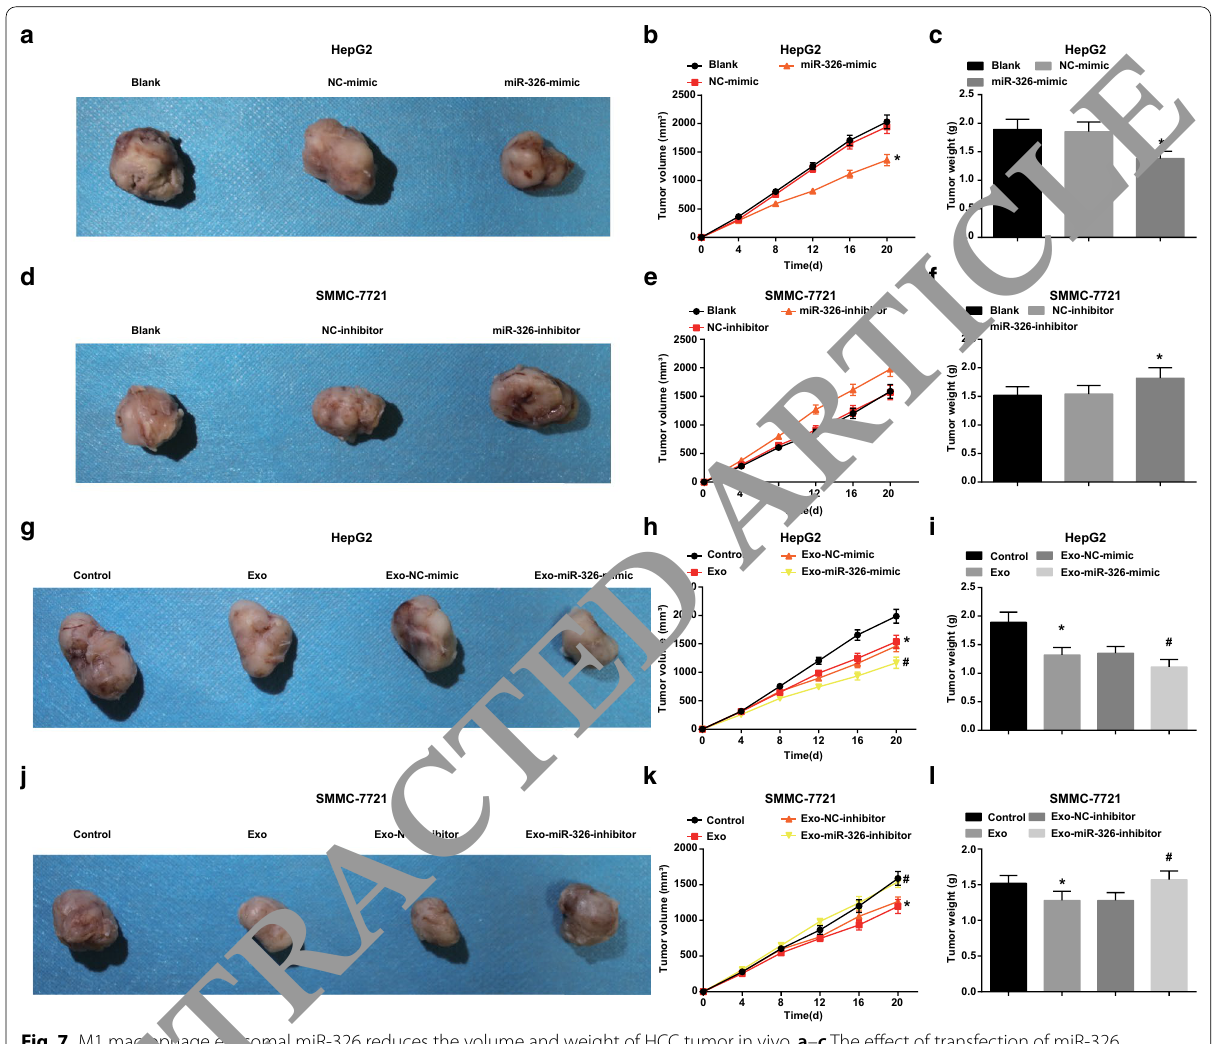
Fig. 7 M1 macrophage exosomal miR‑326 reduces the volume and weight of HCC tumor in vivo. a – c The effect of transfection of miR‑326 mimic on the tumor volume and tumor of nude mice xenografted with HepG2 cells. d – f The effect of transfection of miR‑326 inhibitor on the tumor volume and tumors of nude mice xenografted with SMMC‑7721 cells. g – i The effect of co‑culture with miR‑326 mimic‑transfected M1 macrophage‑derived exosomes on the tumor volume and tumor of nude mice xenografted with HepG2 cells. j – l The effect of co‑culture with miR‑326 inhibitor‑transfected M1 macrophage‑derived exosomes on the tumor volume and tumor of nude mice xenografted with SMMC‑7721 cells. In panel b and c, * P < 0.05 versus the NC‑mimic group; In panel e and f, * P < 0.05 versus the NC‑inhibitor group; In panel h and i, * P < 0.05 versus the control group, # P < 0.05 versus the Exo‑NC‑mimic group; In panel k and l, * P < 0.05 versus the control group, # P < 0.05 versus the Exo‑NC‑inhibitor group. Measurement data were depicted as mean standard deviation ( n 5), comparisons among multiple groups were ± = conducted by one‑way analysis of